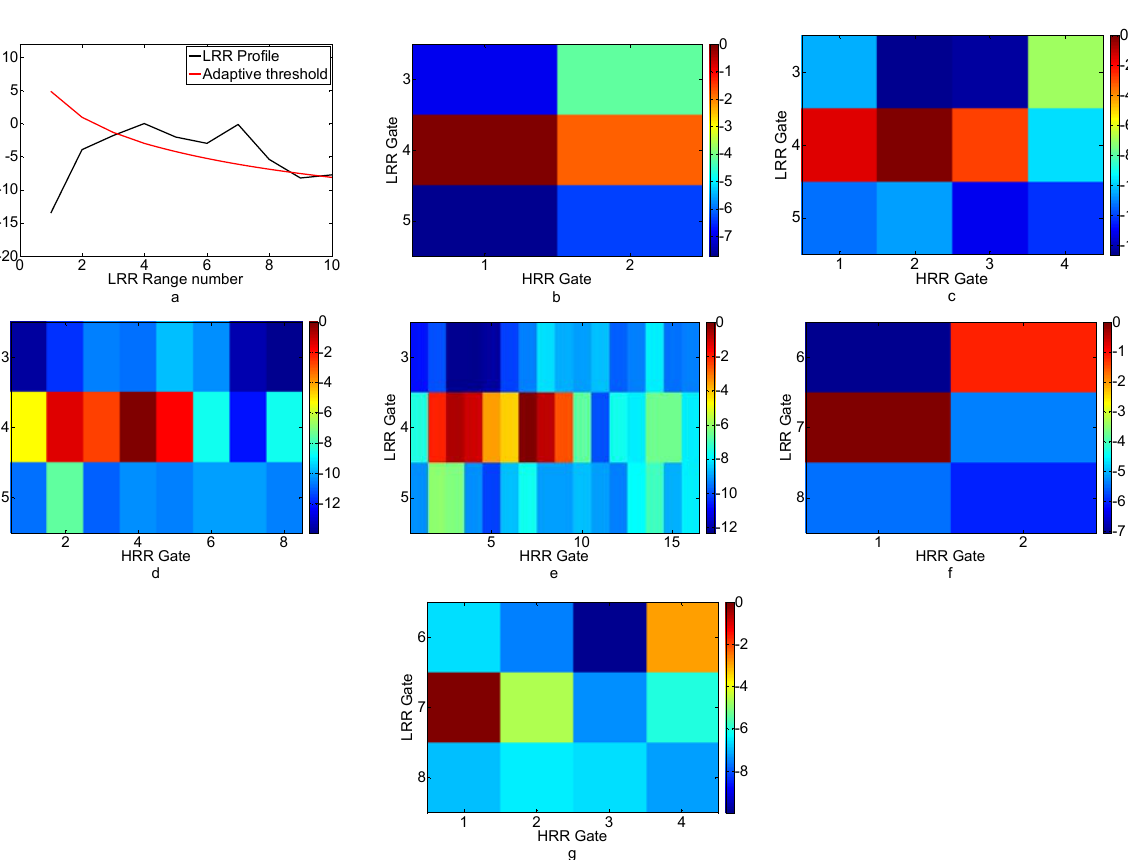
Figure 12. Imaging results for Target Scenario 5. ( a ) Pass 1. ( b ) Pass 2, LRR Gate 4. ( c ) Pass 3, LRR Gate 4. ( d ) Pass 4, LRR Gate 4. ( e ) Pass 5, LRR Gate 4. ( f ) Pass 2, LRR Gate 7. ( g ) Pass 3, LRR Gate